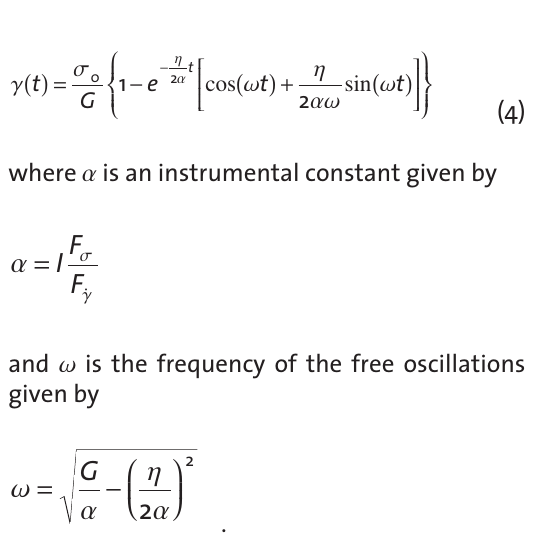
a function of non immersed part of the vane (Eq. 3) for Newtonian fluids of differ- ent viscosity (Glycerin (1.356 Pas), Semisynthetic oil (0.202 Pas), Organic oil (0.072 Pas); Friction coefficient: C = 0.6 µNms -1 ). Experiments performed with an AR 1000 rheometer (TA Instruments; external radius 28 mm, effective radius 9.48 mm, effective height 20.6 mm, radius of inscribed circle 9.52